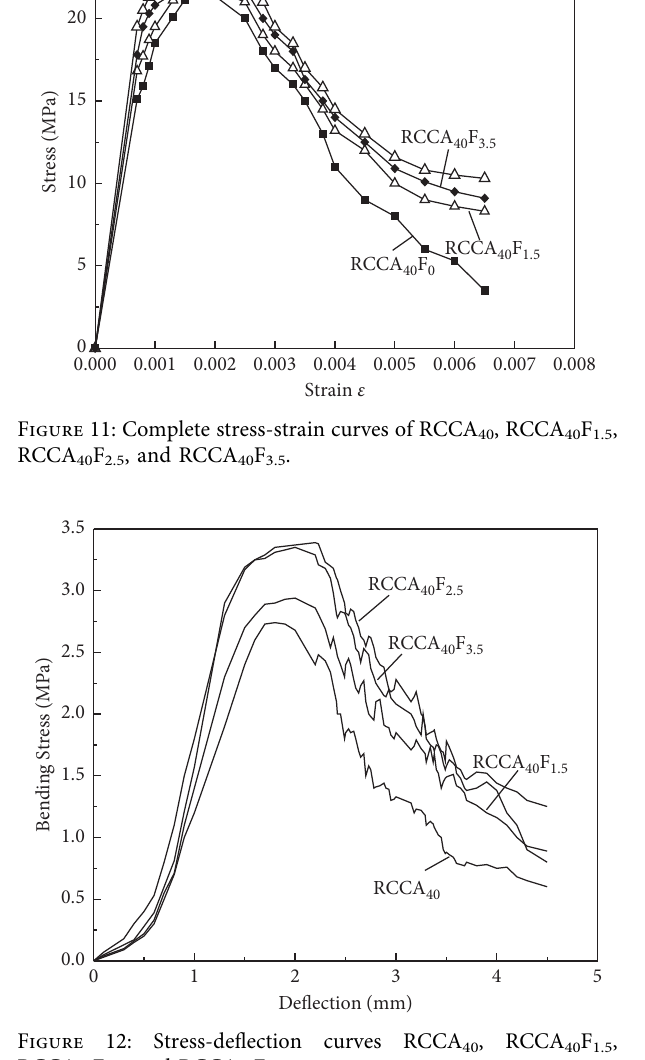
40 , RCCA 40 F 1.5 ,